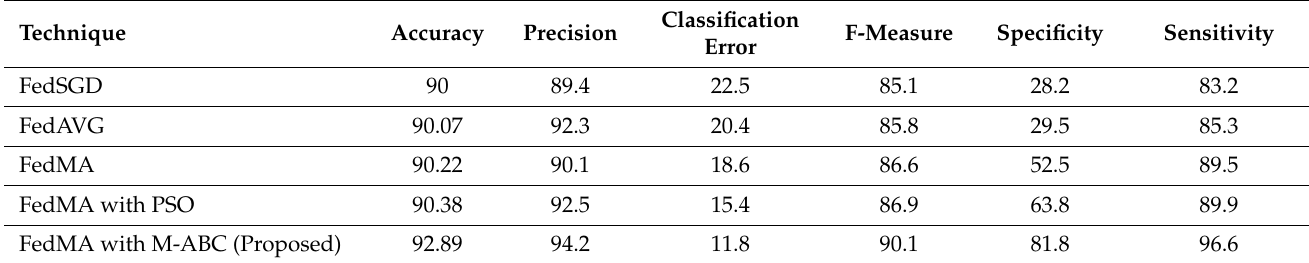
Table 5. Performance on full features set.